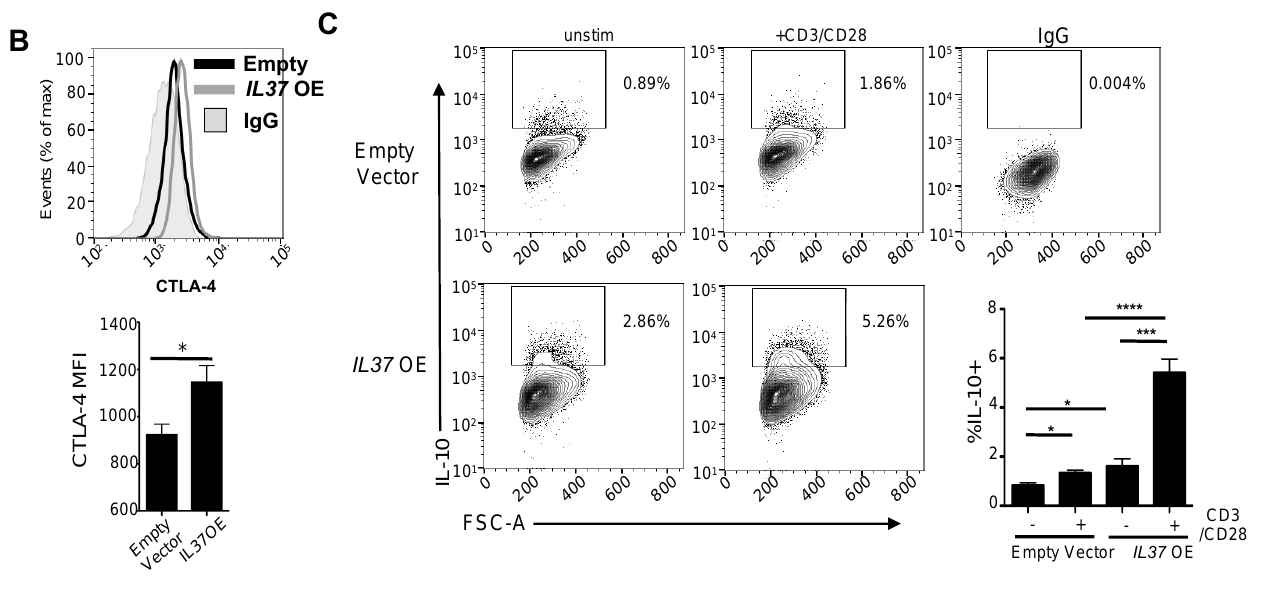
Figure 3 . IL-37 overexpressing Jurkat cells are phenotypically similar to Treg cells. ( A ) qRT-PCR analysis of CTLA4, IL10, GITR , and TGFB mRNA expression in vector control and IL37 OE Jurkat cells. GAPDH served as an internal control, and the values represent the gene expression level as a ratio to GAPDH expression. ( B ) CTLA-4 protein expression in vector control and IL37 OE Jurkat cells. Histograms (upper) and quantification by mean fluorescent intensity (MFI) (lower) of CTLA-4 expression. IgG was used for negative control staining (solid gray histogram). ( C ) Left, contour plots of IL-10+ cell gating in unstimulated and anti-CD3/CD28 treated vector control and IL37 OE Jurkat cells. Right lower, quantification of the percentage of IL-10+ Jurkat cells. IgG was used for gating for positive staining. Small horizontal lines indicate mean ± s.e.m. * p < 0.05; ** p < 0.01; *** p < 0.001; **** p < 0.0001 (Student’s t test). Data are representative of four independent experiments.